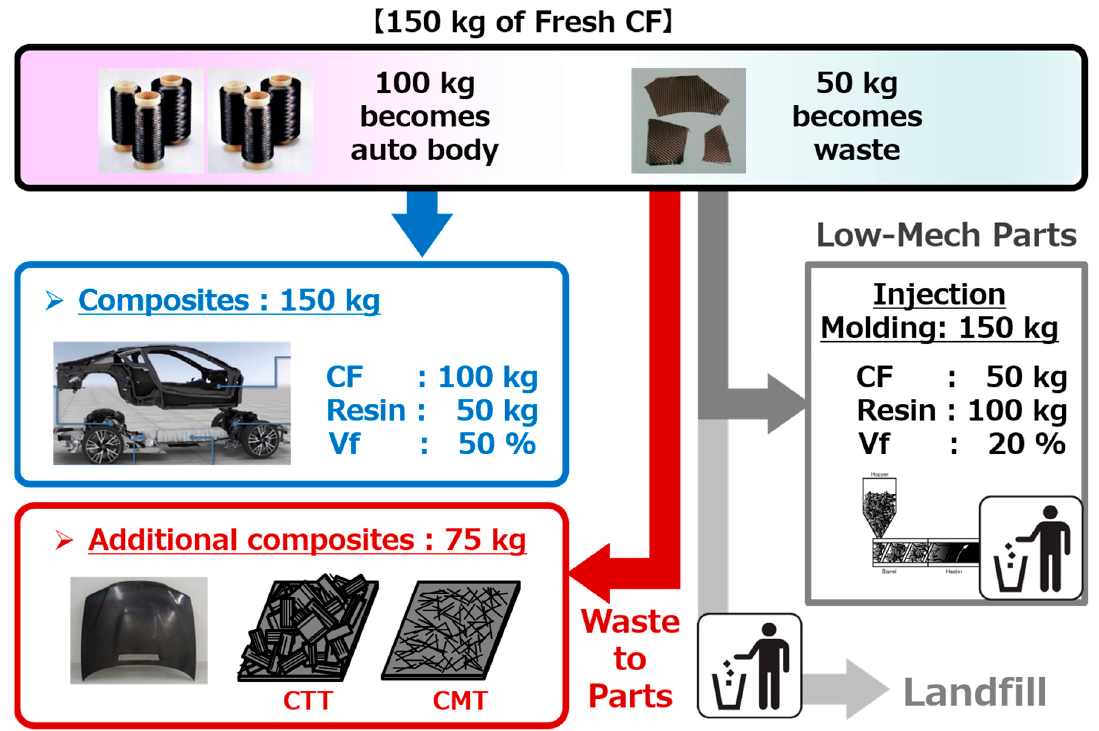
Figure 18. Fabrication processes for automotive CFRP parts with discontinuous CFRTPs.